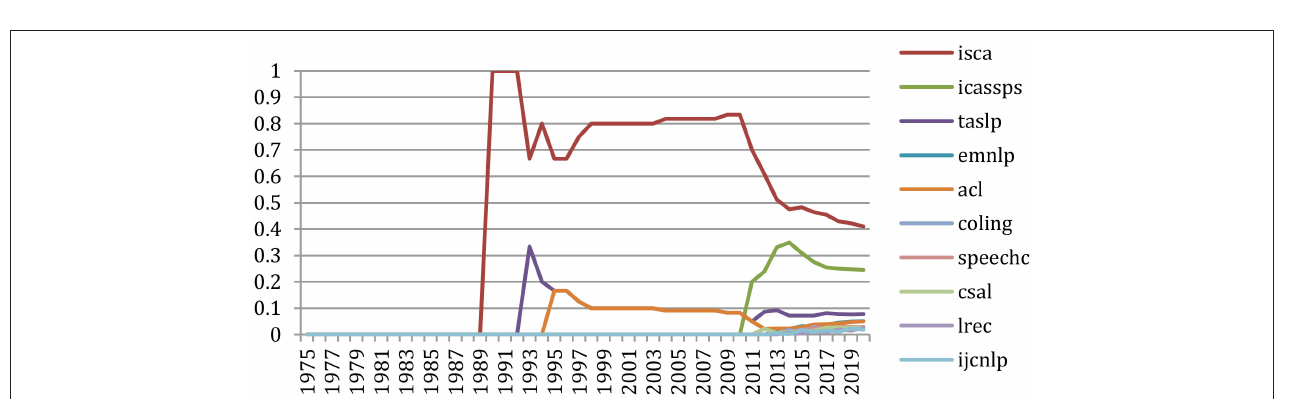
FIGURE 46 | Cumulative sources’ contributions to “DNN” in speech processing and NLP (% of topical papers).